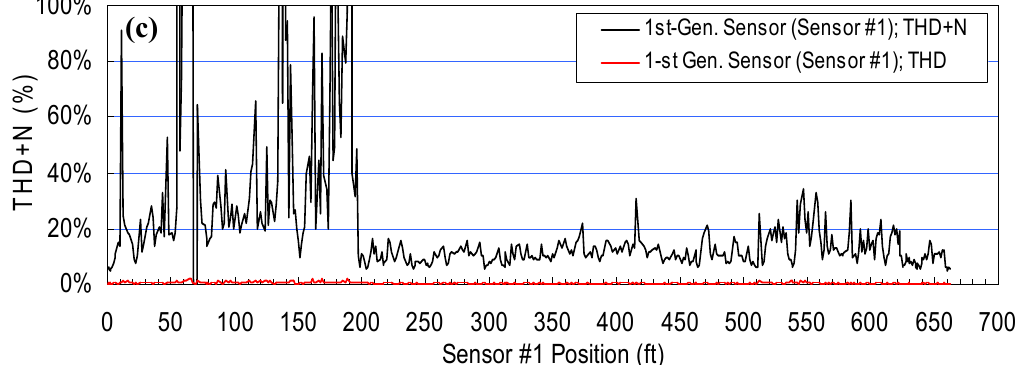
Figure 12. RDD measurements using the old rolling sensor (referred as first generation sensor) at 1 mph along the JCP: ( a ) Continuous deflection profile, ( b ) continuous SINAD profile, and ( c ) continuous THD + N and THD profiles.